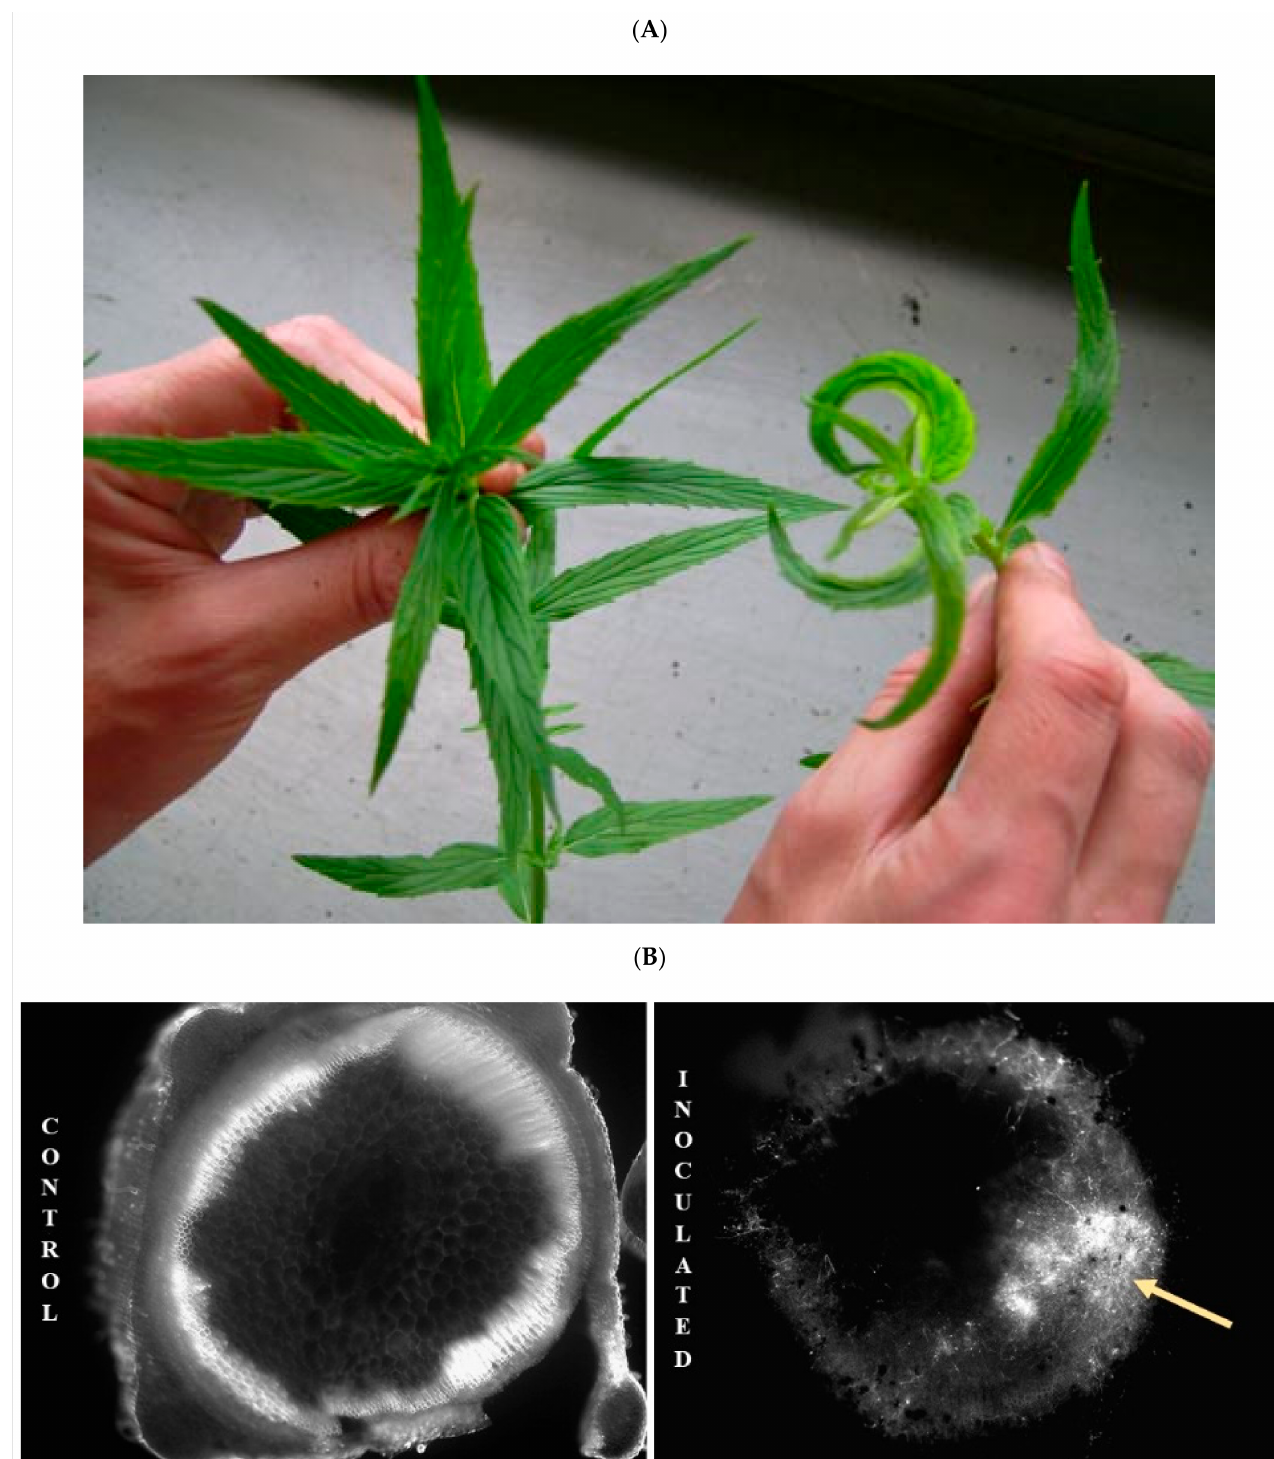
Figure 1. Verticillium wilt disease symptoms in mint. ( A ). Left: uninoculated M. longifolia . Right: V. dahliae -inoculated M. longifolia displaying chlorosis and crescent leaf symptoms. ( B ). M. longifolia stem cross-sections were taken 20 days after plants were root dipped in either water (control) or a spore suspension of GFP-labeled V. dahliae (inoculated). Stem sections were incubated on water/agar for several days before examining by fluorescent microscopy and imaging. The arrow shows GFP- labeled fungal